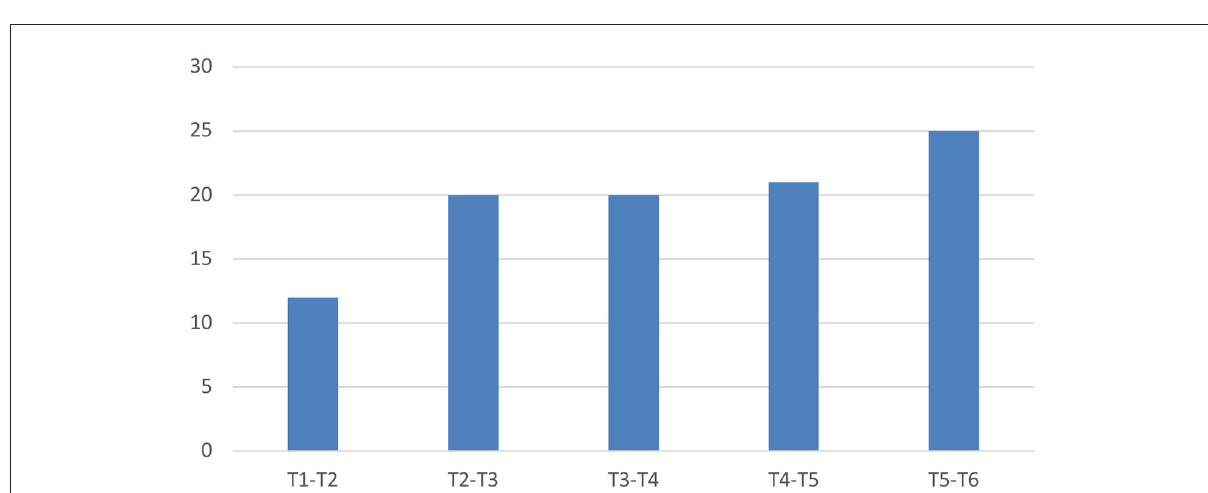
FIGURE4 Lesion location if a block of two vertebrae and their intervertebral disc space is